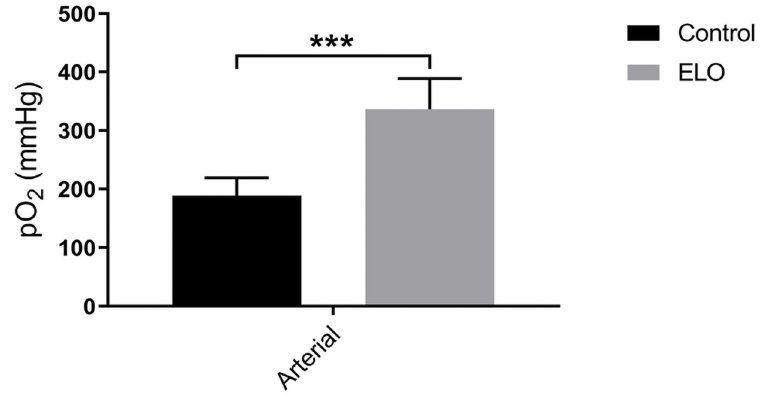
Fig 3. Comparing arterial pO2 between ELO water-treated rats and rats drinking control water. Arterial pO2 was significantly higher with ELO water ( ��� , p < 0.01).